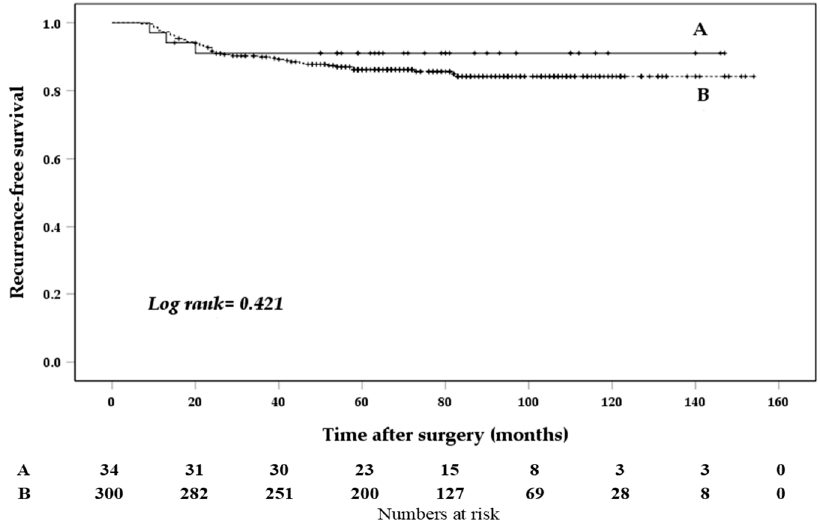
Figure 2. Kaplan-Meier curve according to the presence and absence of skip metastases. Skip me-